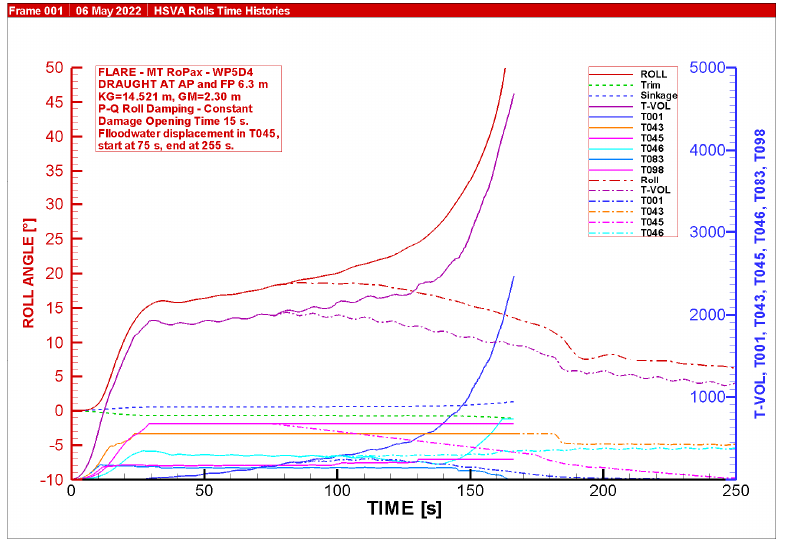
Figure 12. Recovery of lost buoyancy with damage opening time 15 s: The roll angle (red) and water volumes on trailer deck (blue) and in damaged compartments (bluish, reddish, deep yellow) and in the compartment T045 (pink solid/dash-dotted curves) chosen for floodwater displacement. T-VOL is the total volume of the flood water in ship, T001 the water volume on the trailer deck.